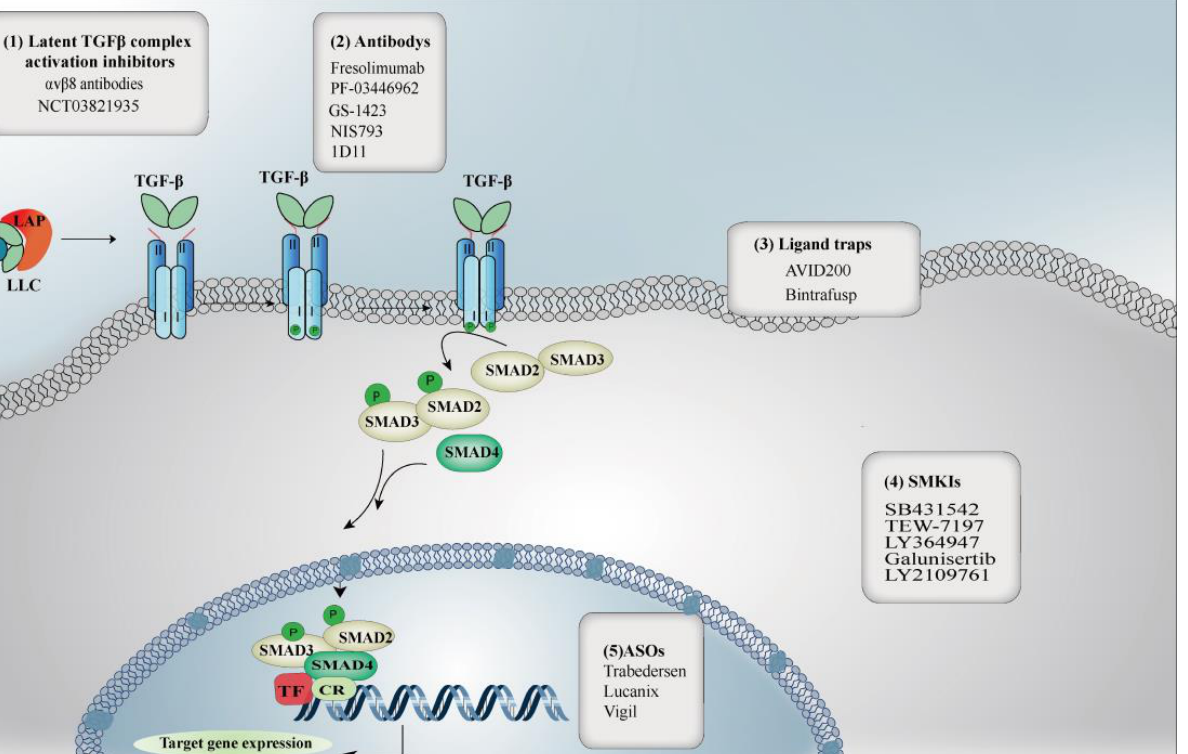
Figure 1. The representational blockers of the potential design targets along with TGF- β/Smad sig-